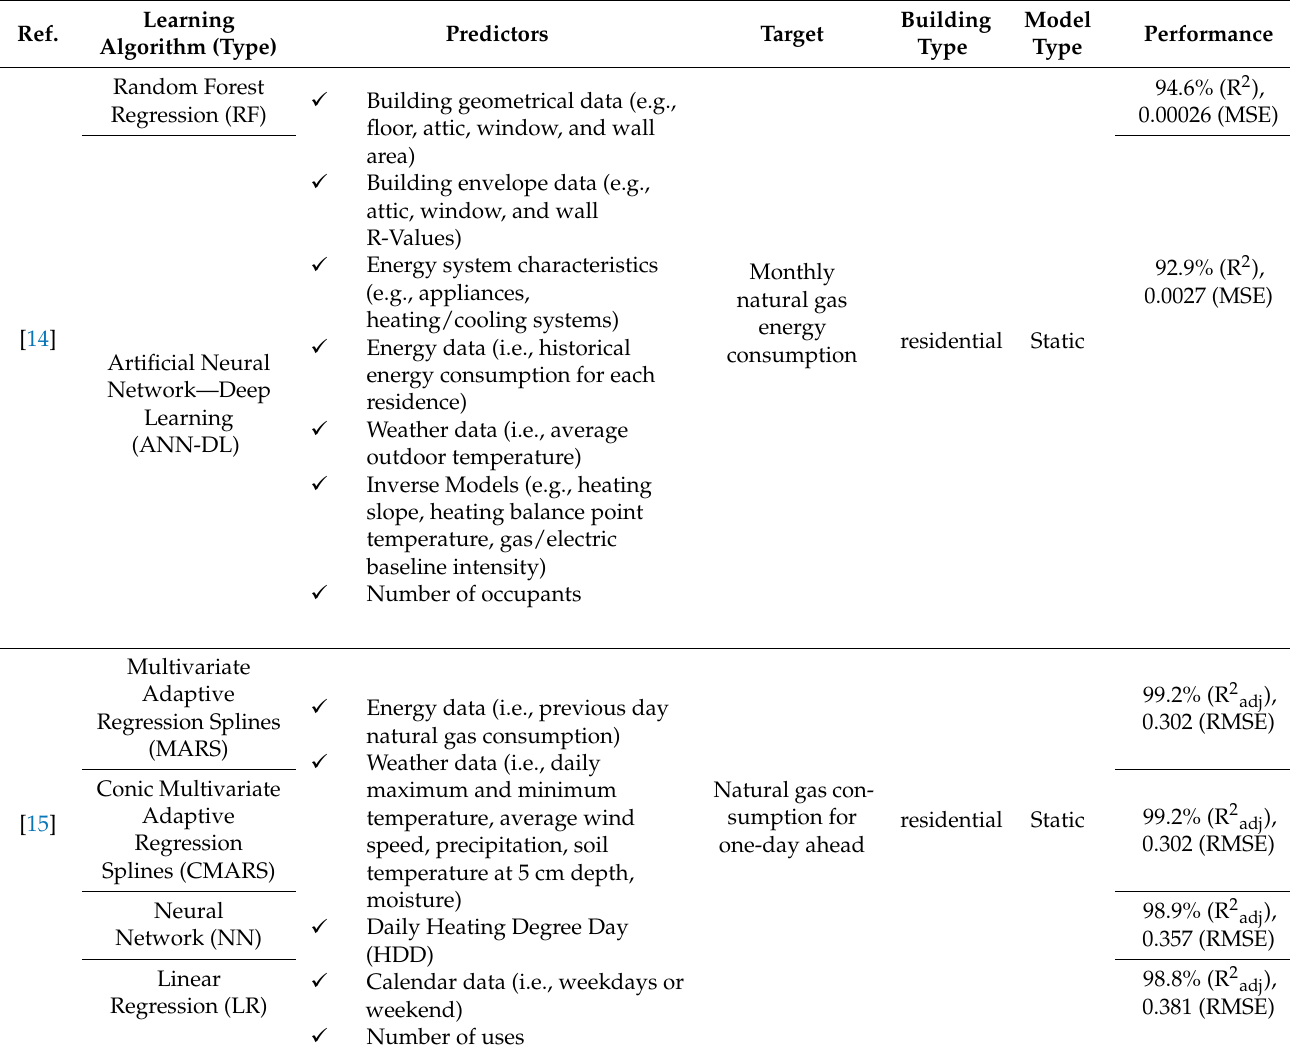
Table 1. Summary of prior research in predicting energy consumption in residential buildings.